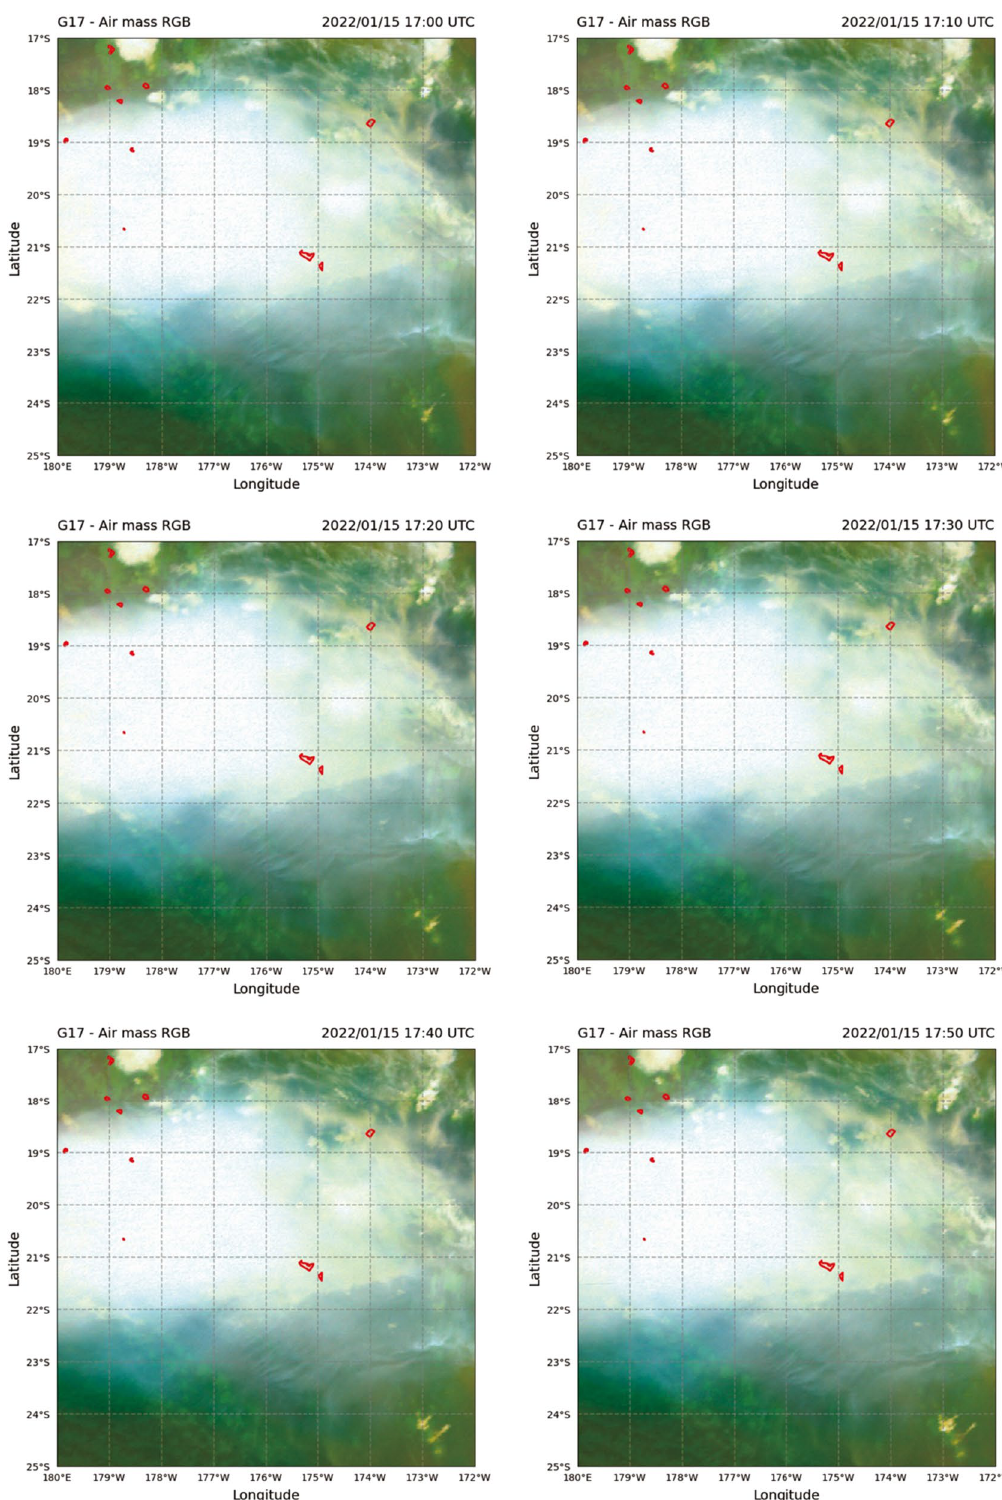
Fig. 16 Air mass RGB using GOES-17 from 17:00 to 17:50 on 15 January